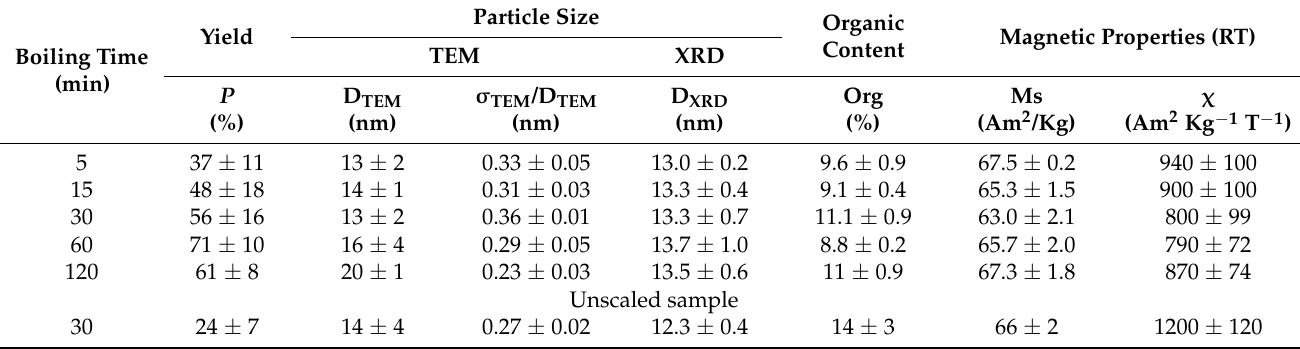
Table 1. Average values of the six repetitions are reported here for the yield, particle size and polydispersity (TEM), crystallite size (XRD), organic content (TG-ATD), and magnetic properties at RT (Ms = saturation magnetization per mas of material, χ = susceptibility) as a function of the boiling time. The results for the unscaled samples obtained at 30 min boiling time are shown as reference. This table reports the arithmetic averages and the error of the averages with 95% confidence (see